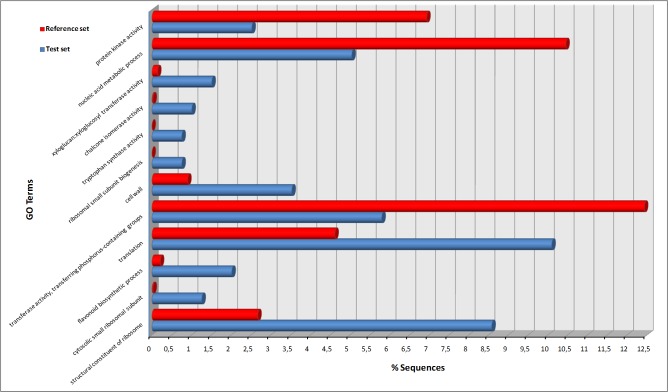
Enriched GO terms for RR-TIG DGEs.The bar chart shows for each significant GO termthe amount (percentage) of annotated transcripts Blue bars correspond to the sequences of the test-set and red bars correspond to the reference transcriptome dataset.